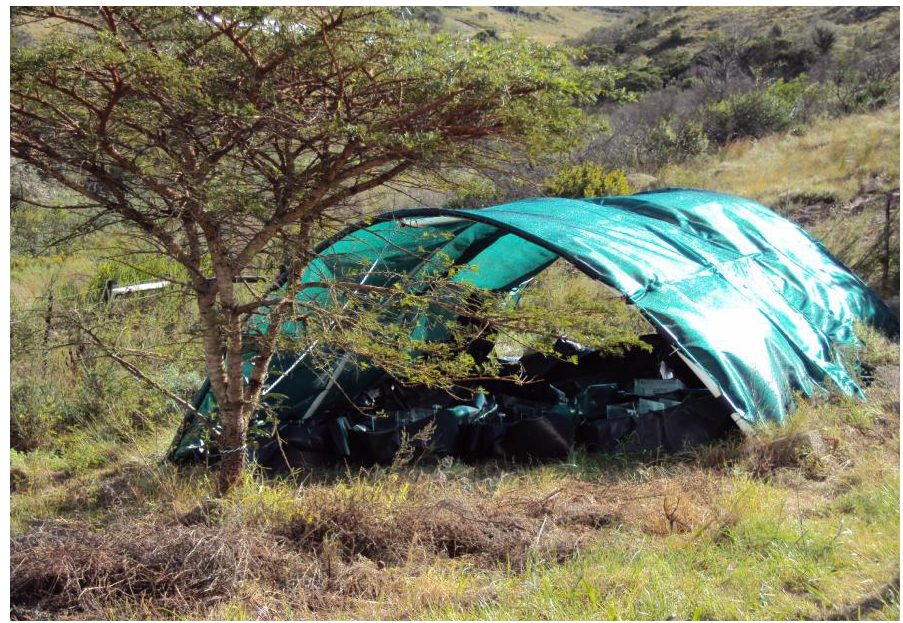
Figure 2. Photograph showing the natural laboratory.